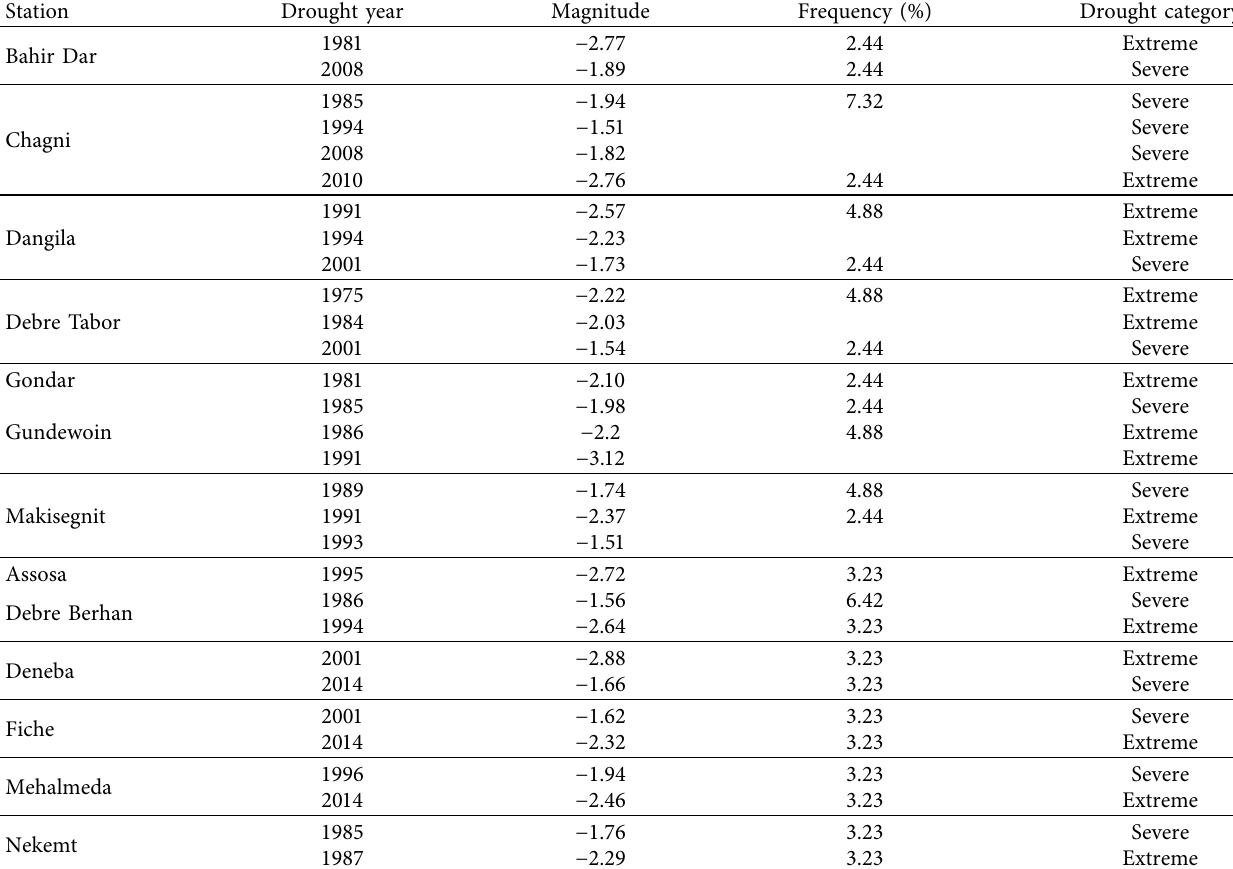
Table 4: Severe and extreme drought years in the Abbay river basin during 1973–2014 in SPI12.